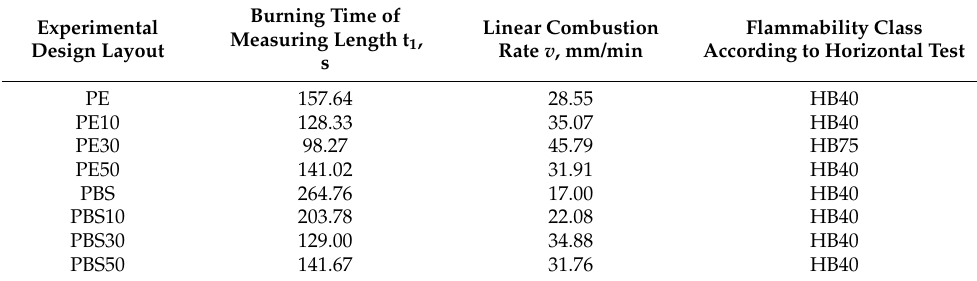
Table 2. Results of horizontal flammability